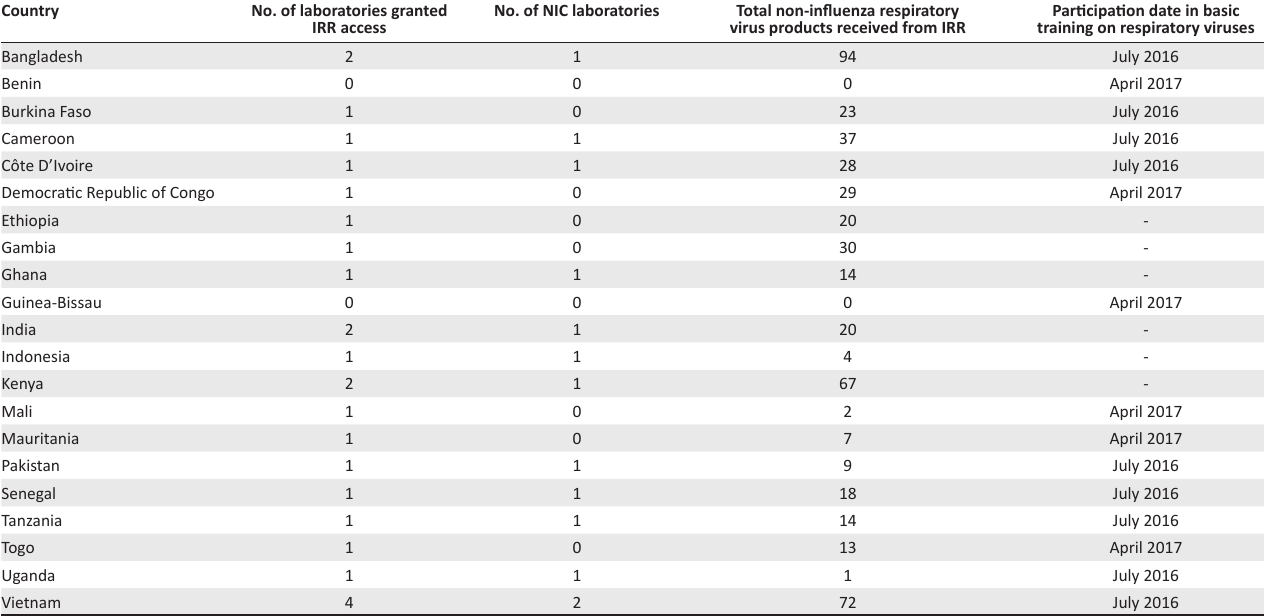
TABLE 1: Countries with expanded non-influenza virus reagent access that engaged in strengthening activities (February 2016–September 2017).